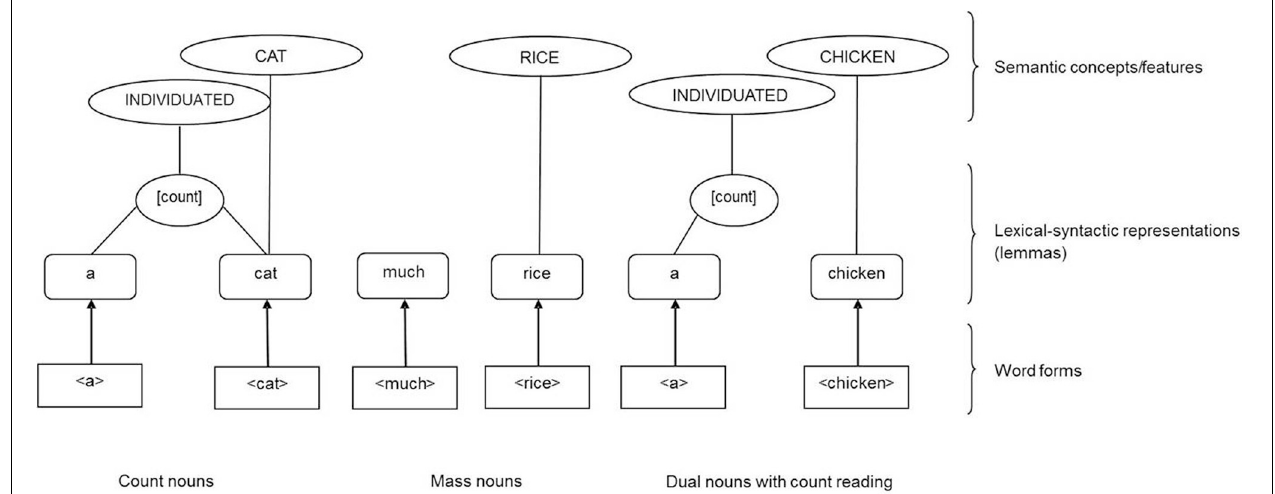
FIGURE 3 | Lexical representation of count, mass and dual nouns with count reading adapted from Barner and Snedeker (2005, 2006). The mass-count distinction is based on the single lexical-syntactic attribute [ + individual]. Count nouns and their syntactic context (e.g., count noun determiners: a, many) activate the lexical-syntactic attribute [ + individual] which allows the semantic and/or conceptual specification for “individuated.” To adapt Barner and Snedeker’s theory to other theories (Levelt et al., 1999; Taler and Jarema, 2006), we use the term